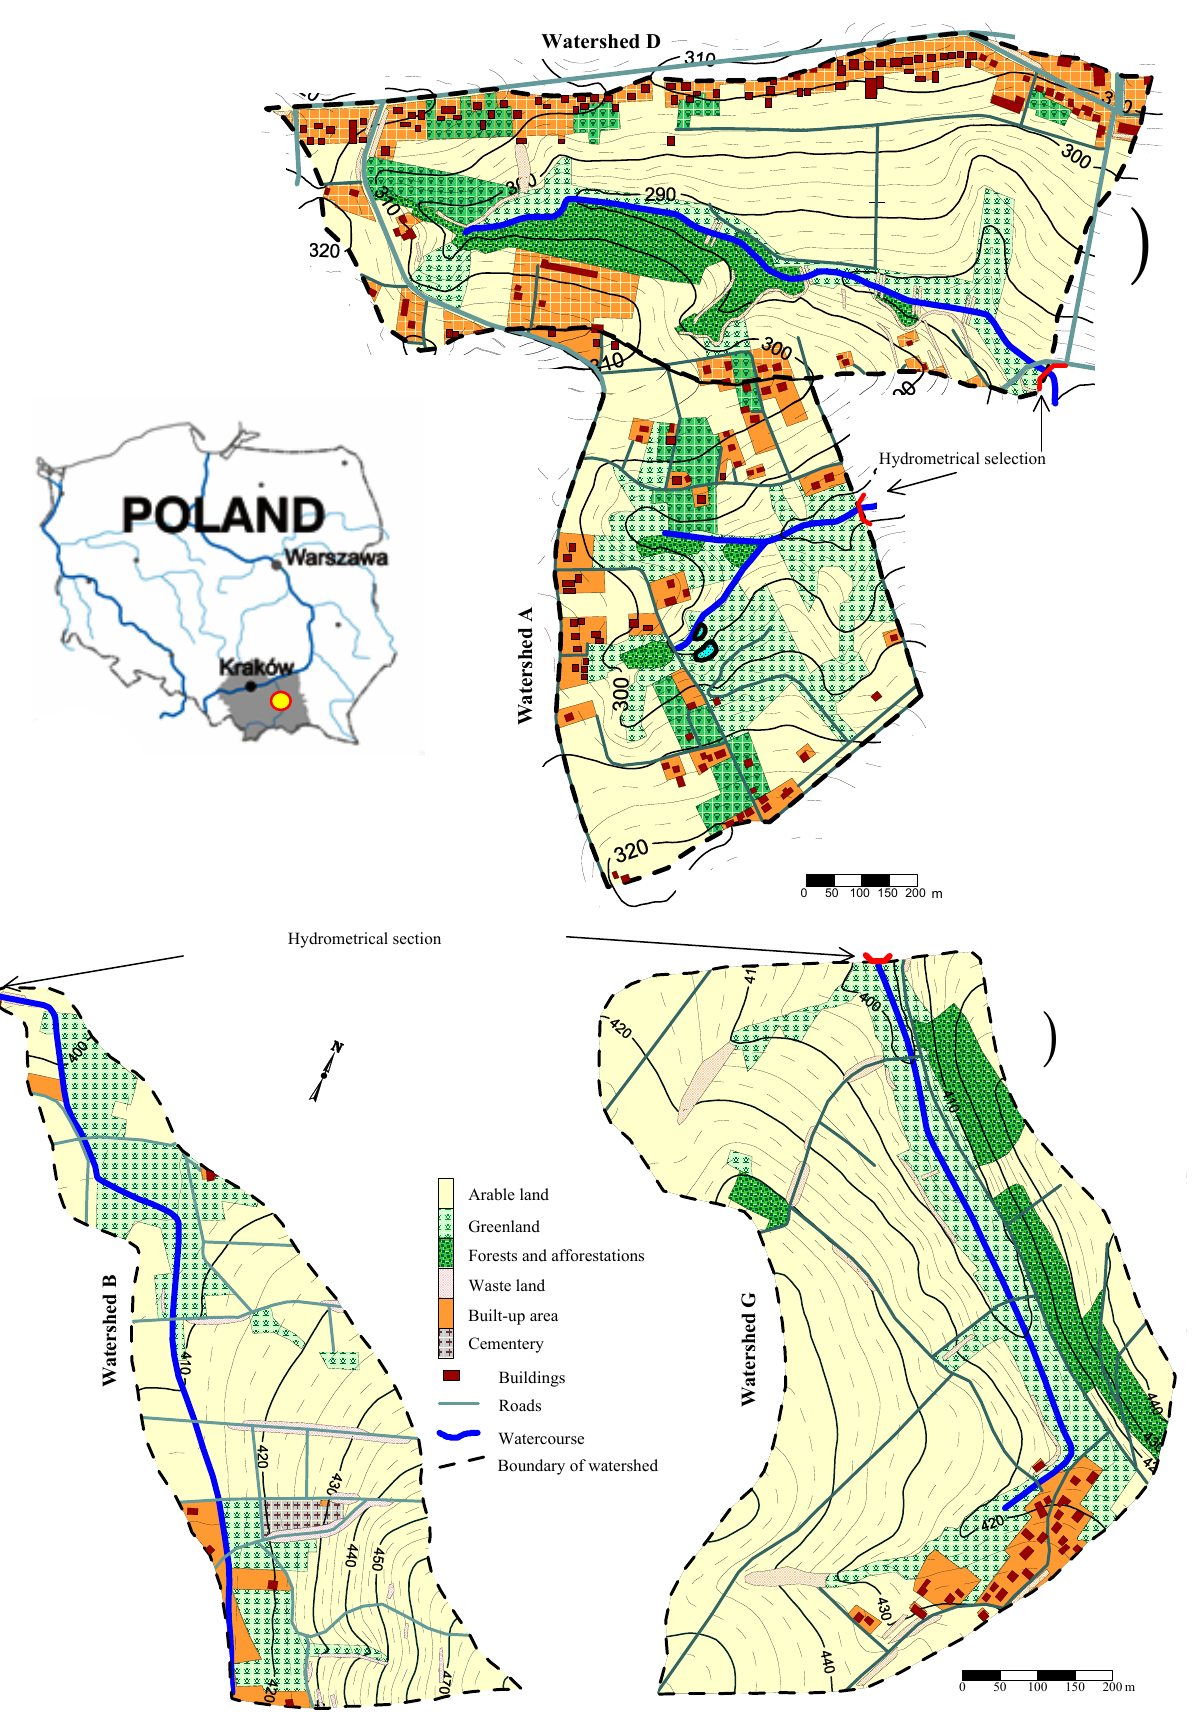
Figure 1. Investigated